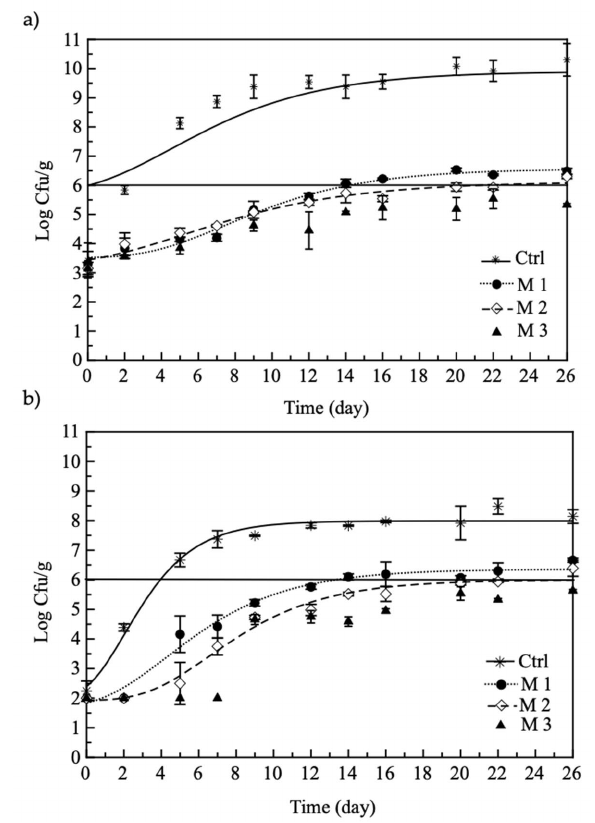
Figure 4. Evolution of Pseudomonas spp. ( a ) and S. putrefaciens ( b ) in fish burgers during storage at 4 °C. Data are presented as mean ± SD. Symbols: experimental data; solid line: threshold for microbial acceptability set to 106 CFU/g. Ctrl: fish burger; M1: fish burger with mix of juice and re-ground pomegranate powders; M2: fish burger with mix of juice, water and re-ground pomegranate powders; M3: fish burger with mix of juice and ground pomegranate powders.